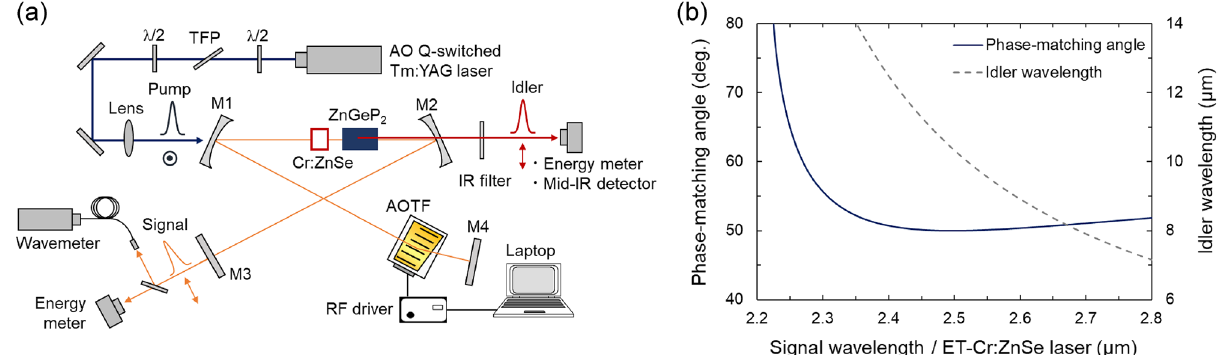
Figure 1. ( a ) Schematic of the experimental setup. TFP, thin-film polarizer: AOTF, acousto-optic tunable filter; M1, folding pump mirror; M2, folding mirror for extracting the idler; M3, output coupler for the ET-Cr:ZnSe laser; and M4, total reflector. ( b ) PM tuning curve for type-1 DFG in ZGP at 20 °C. Pump and signal waves are given by the Tm:YAG laser (2.013 μm) and ET-Cr:ZnSe laser,